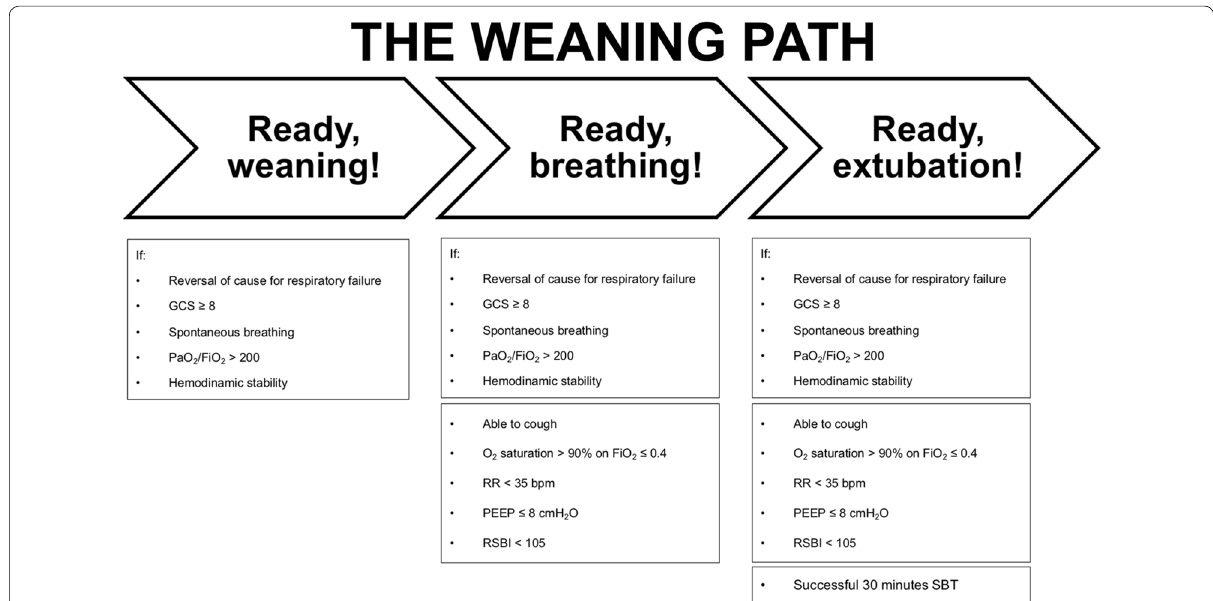
Fig. 1 The weaning path. GCS Glasgow Coma Scale, RR respiratory rate, PEEP positive end-expiratory pressure, RSBI rapid shallow breathing index, SBT spontaneous breathing